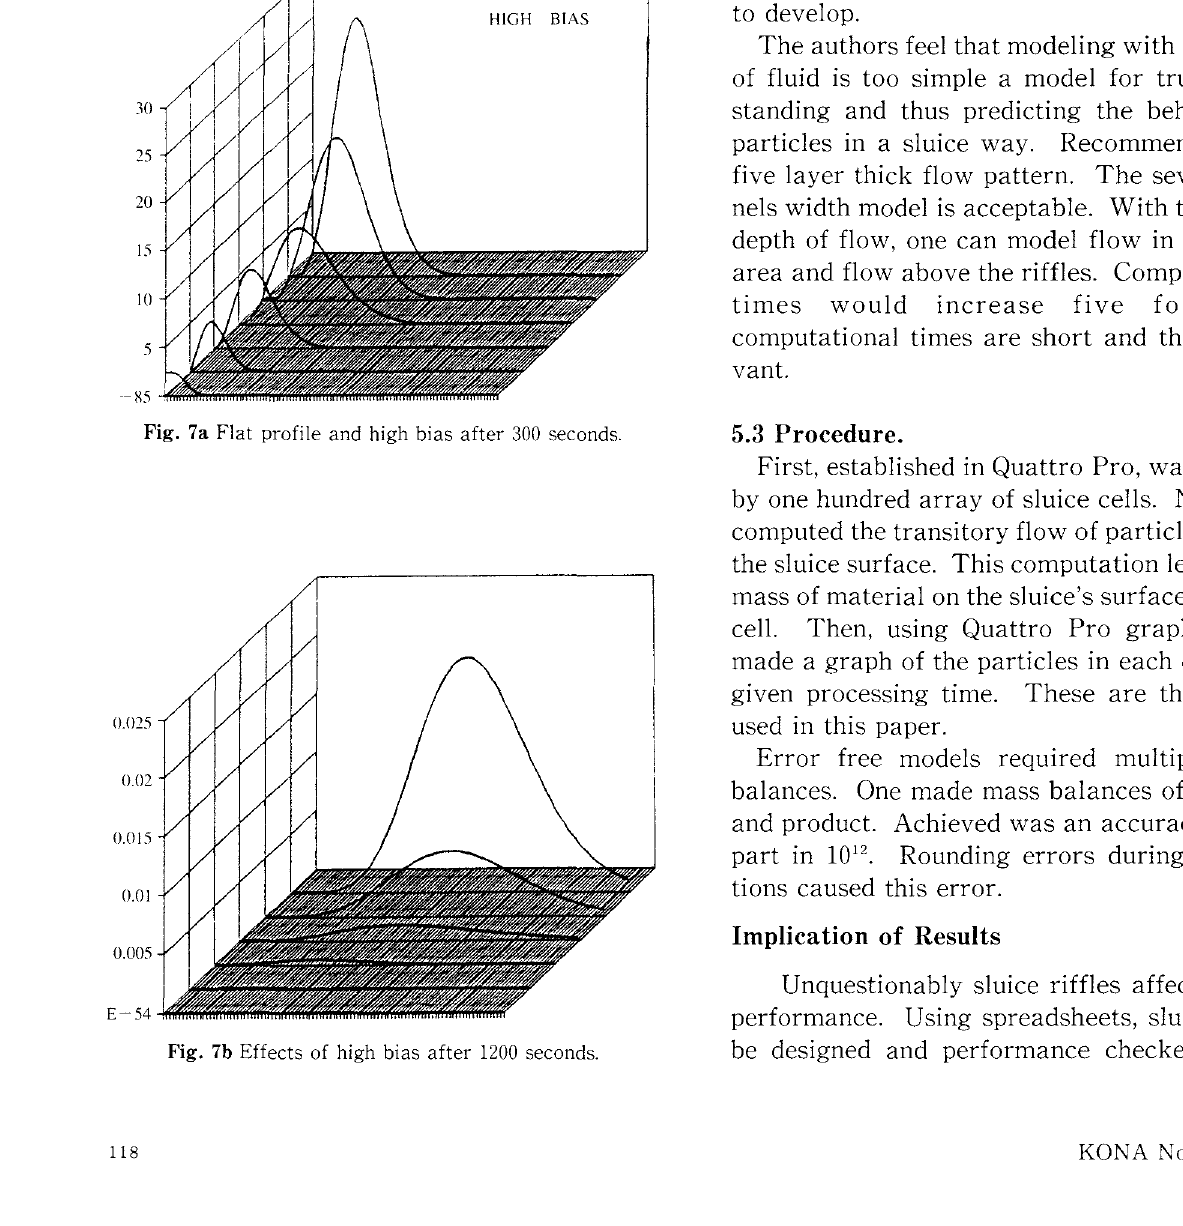
Fig. 7b Effects of high bias after 1200